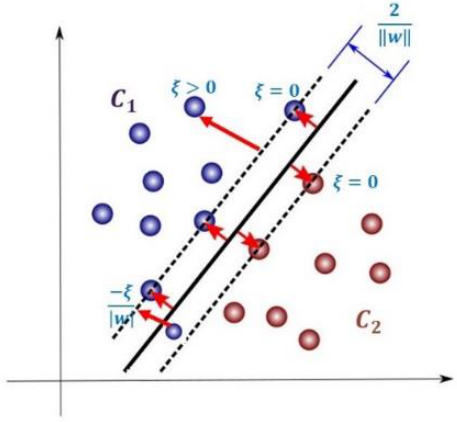
Figure 8. The soft margin support vector machines (SVM).